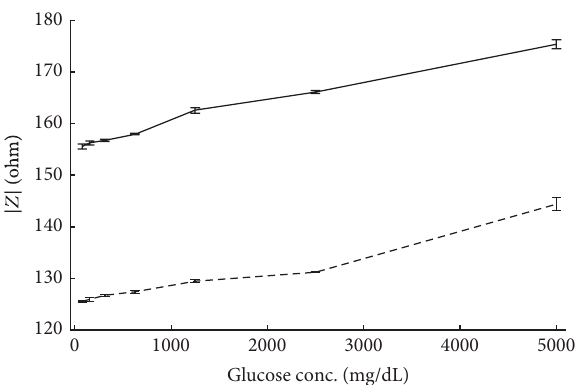
C (b). Data reported are mean SE. ∘ ±